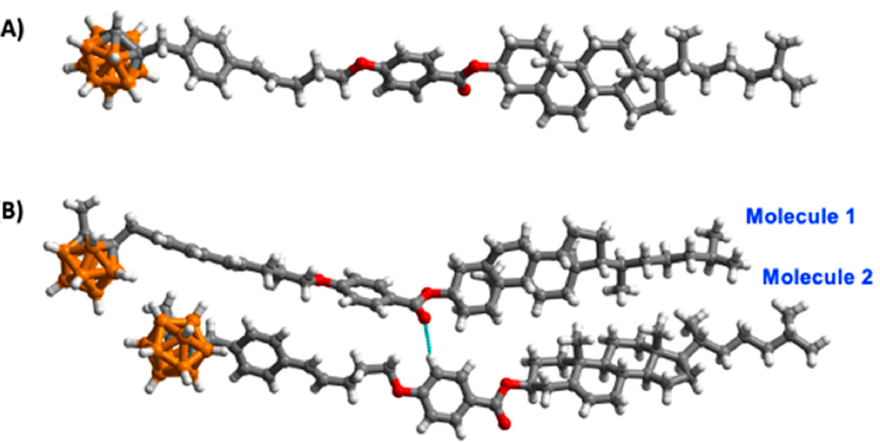
Figure 1. View of independent molecules in the unit cell of M2 ( A ) and M3 ( B ). Intermolecular contacts are shown as dotted blue lines. Color codes: H white; C gray; O red; B orange.